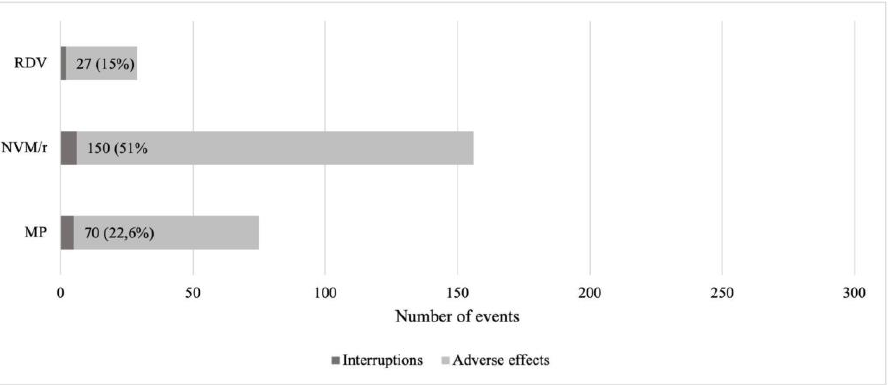
Figure 5. Frequency of self-reported adverse effects and interruptions in the three groups of treatment. MP: molnupiravir, NVM/r: nirmatrelvir/ritonavir, RDV: remdesivir. MP vs. RDV p- Value 0.0001; NVM/r vs. RDV p- Value 0.0001.